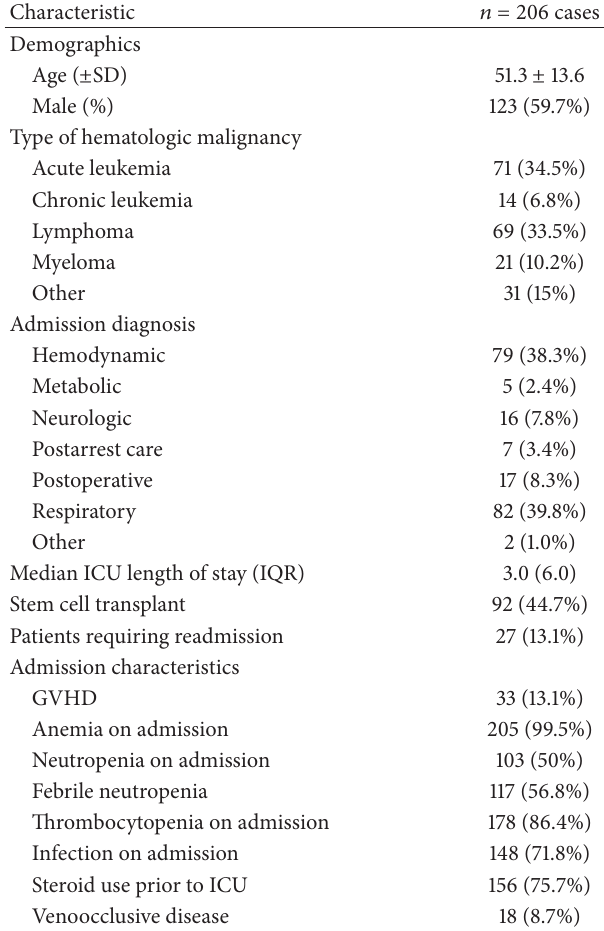
Table 1: Baseline characteristics of study participants.